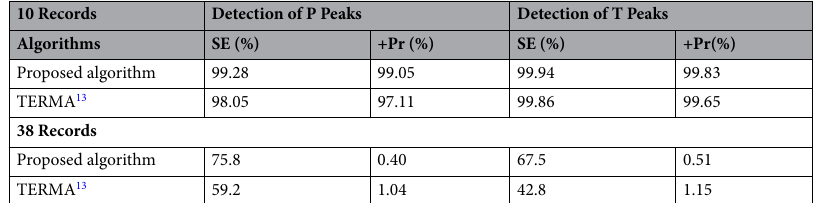
10 Records Detection of P Peaks